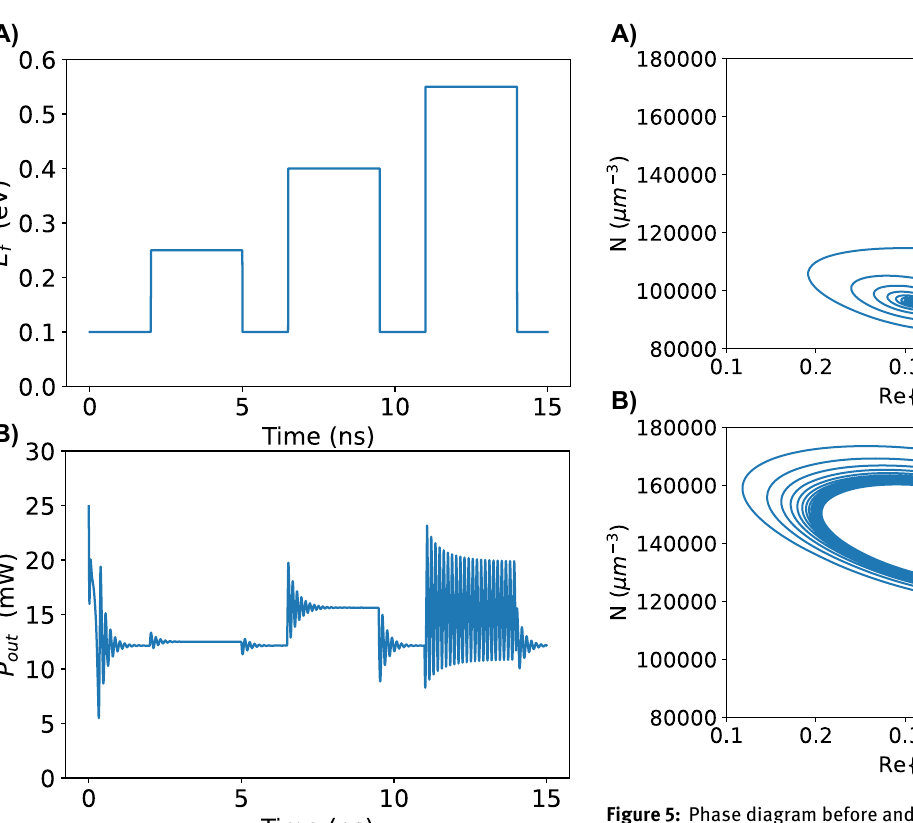
Figure 4: Tuning the Fermi level to induce dynamic behavior. (A) The applied Fermi level pulsed in time. (B) The resultant output power in the bus waveguide.